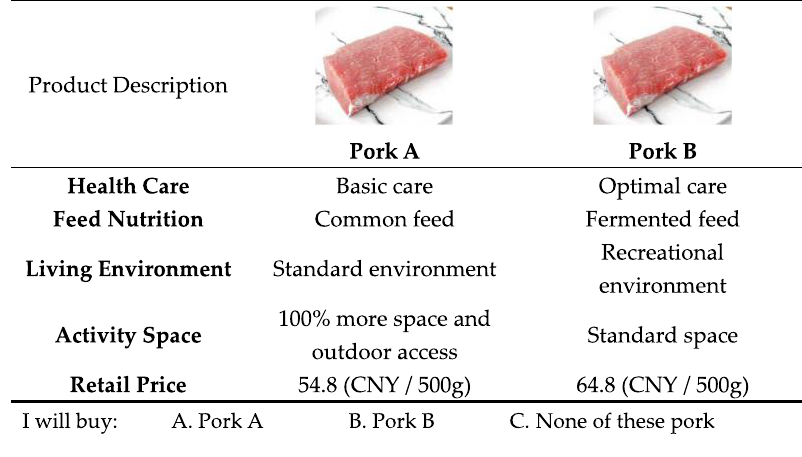
Figure 2. Sample of a choice set.